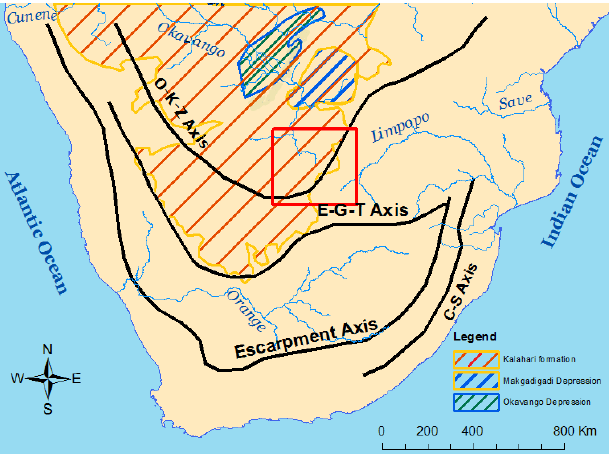
Figure 6. Axes of crustal flexure of southern Africa defining the major water divides (adapted from Moore,